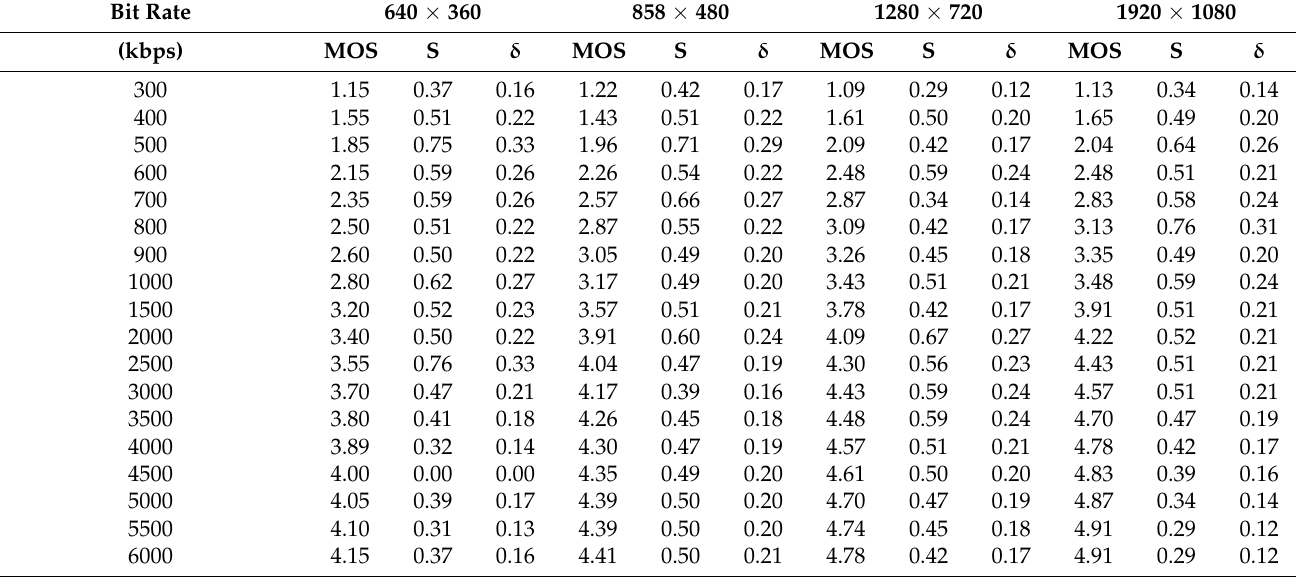
Figure 9. Results of the subjective quality assessment (MOS) for the H.265-encoded video as a func- tion of bit rate for different spatial resolutions—measurements in the laboratory.